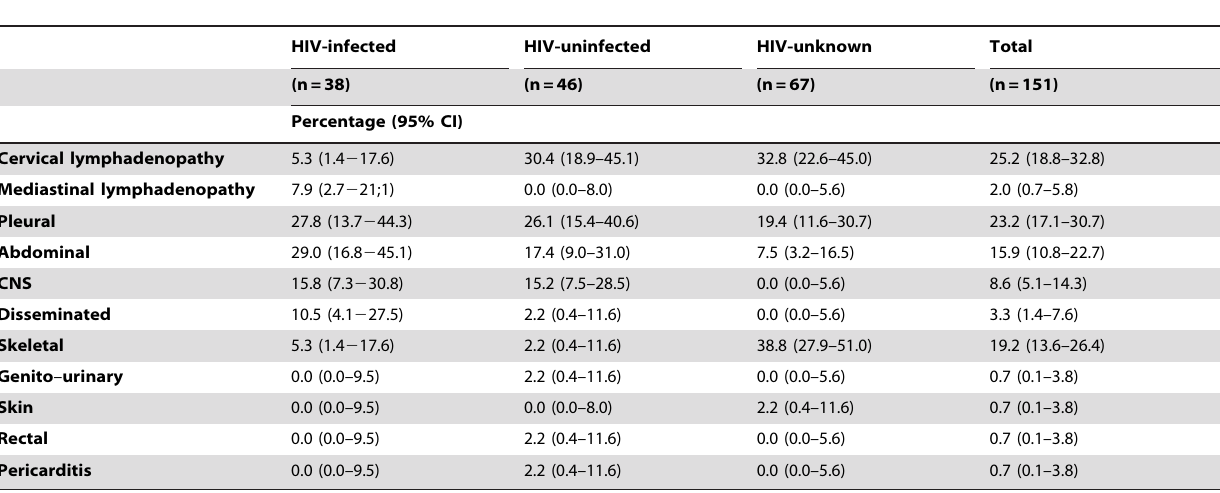
Table 2. Extrapulmonary TB localizations according to HIV